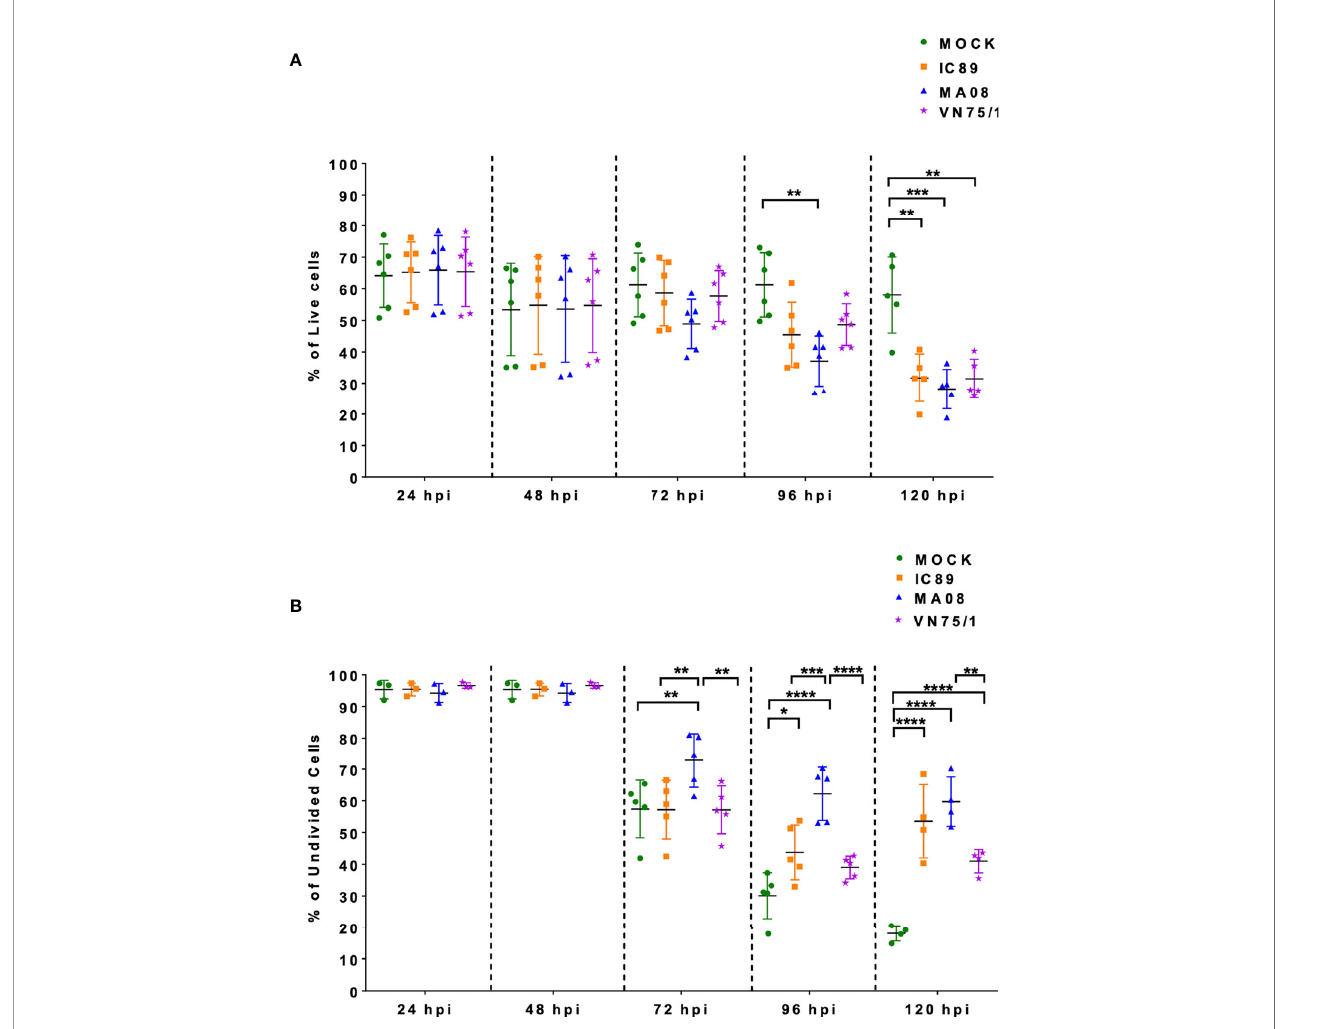
FIGURE 1 | Effect of PPRV strains on ConA stimulated PBMC survival and proliferation over a period of fi ve days. (A) Viability of the cells during infection expressed as the percentage of live cells (7AAD negative cells). (B) Frequencies of undivided cells after infection with the different virus strains. Five goats were used to obtain PBMCs. Goat PBMCs were infected with PPRV strains IC89, MA08 and VN75/1 at MOI of 0.001. The sixth point observed in 1A represents an additional experiment performed on one animal to con fi rm the results obtained. P-values were calculated using two-way ANOVA: “ * ” = P-values < 0.05; “ ** ” = P-values < 0.01; “ *** ” = P-values < 0.001; “ **** ” = P-values <